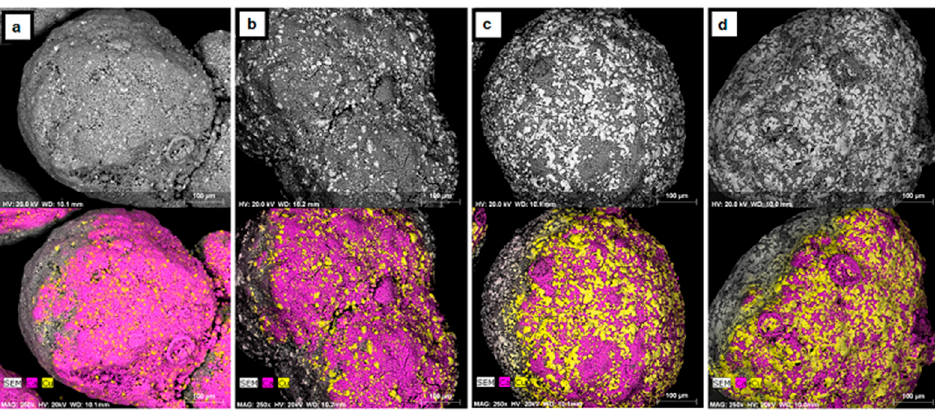
Figure 4. SEM micrographs with corresponding EDX maps of CaO/CuO pellets after ( a ) 0; ( b ) 5; ( c ) 10; and ( d ) 15 cycles of CaL and CLC. The elements Ca and Cu are represented in purple and yellow, respectively.